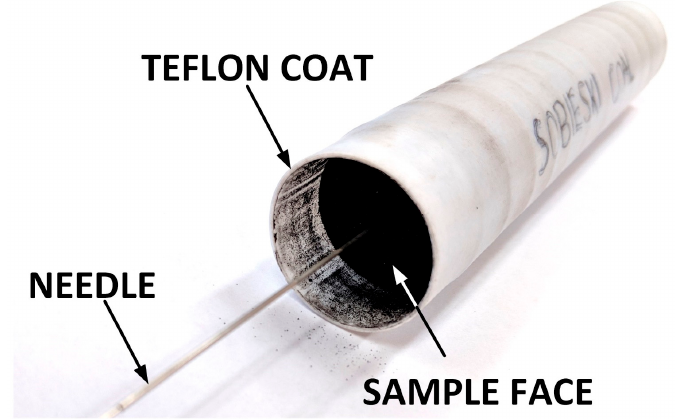
Figure 2. Coal briquette sample prepared for measurements.